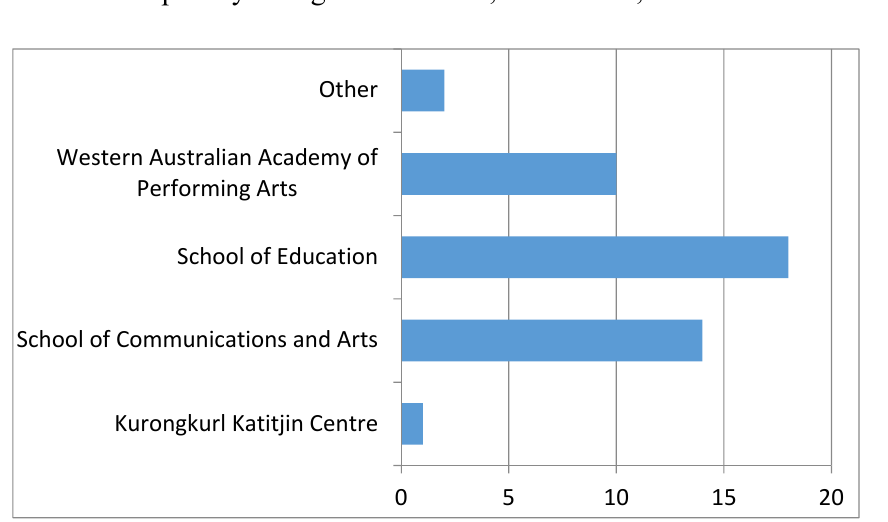
Figure 4. Affiliations of Faculty